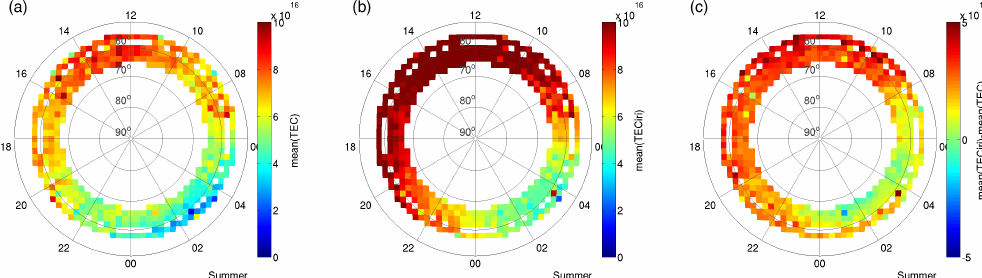
Figure 6. Magnetic local time mean values for summer time tomographic VTEC, corresponding IRI-2012 values and the difference between the